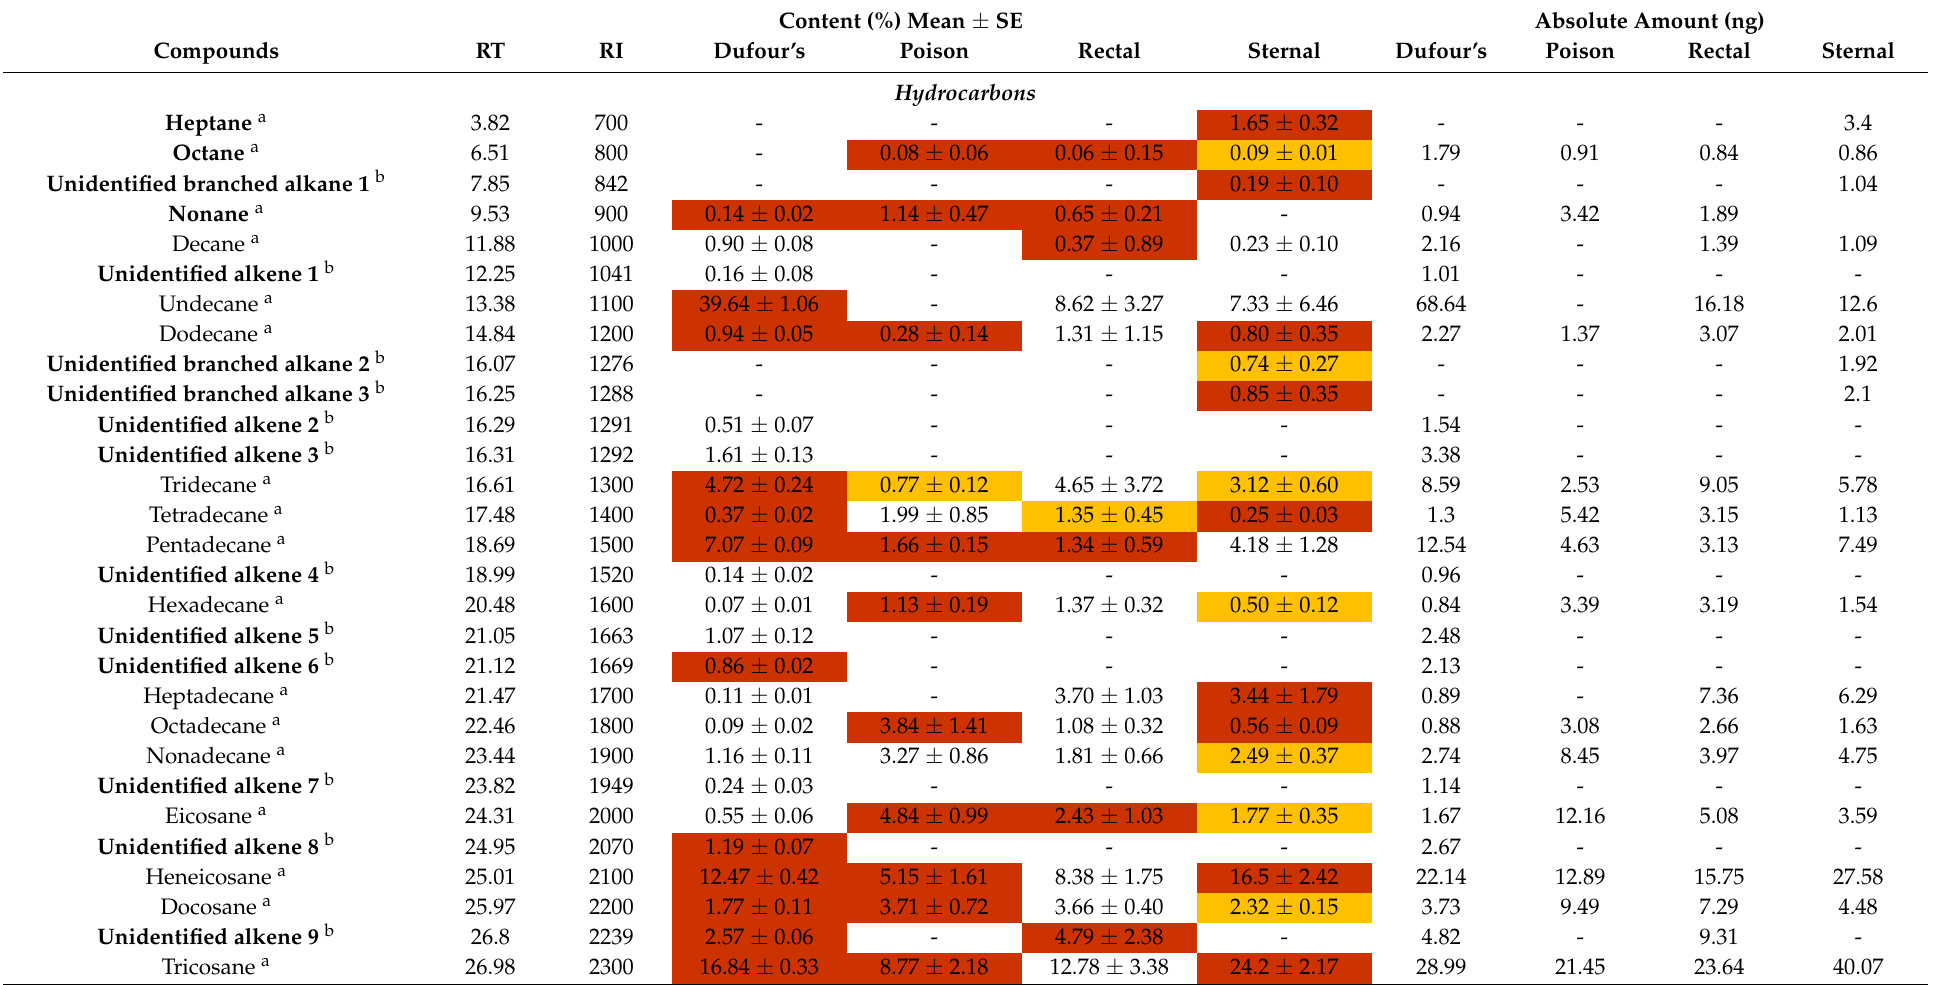
Table 1. Percentage compositions and amounts of compounds detected in Dufour’s, poison, sternal, and rectal gland extracts of major workers of Oecophylla longinoda